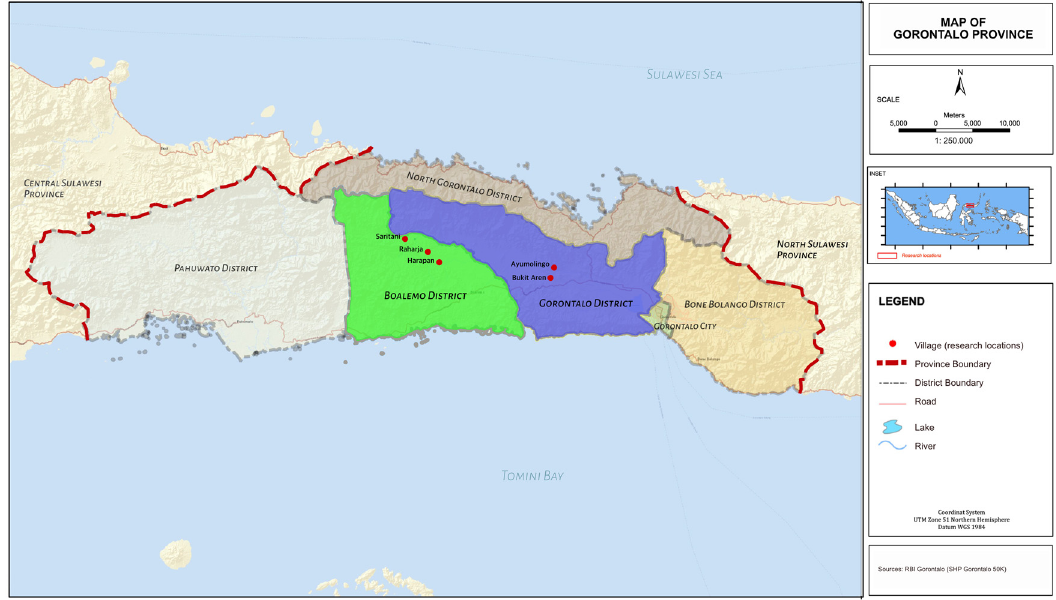
Figure 1: Location of fi ve villages as research site in Boalemo and Gorontalo district map of Gorontalo province,